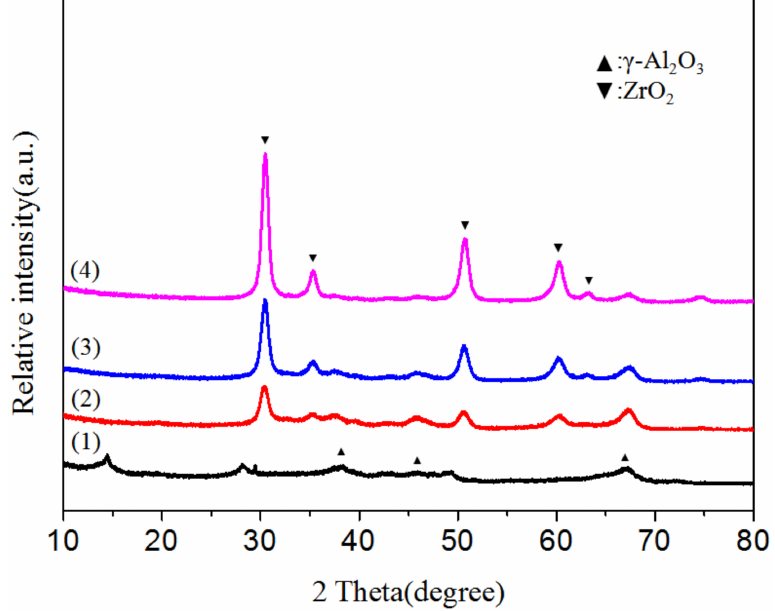
Figure 2. XRD patterns of catalysts as prepared, ( 1 ) γ -Al 2 O 3 , ( 2 ) 9% Zr/ γ -Al 2 O 3 , ( 3 ) 16% Zr/ γ -Al 2 O 3 and ( 4 ) 35% Zr/ γ -Al 2 O 3